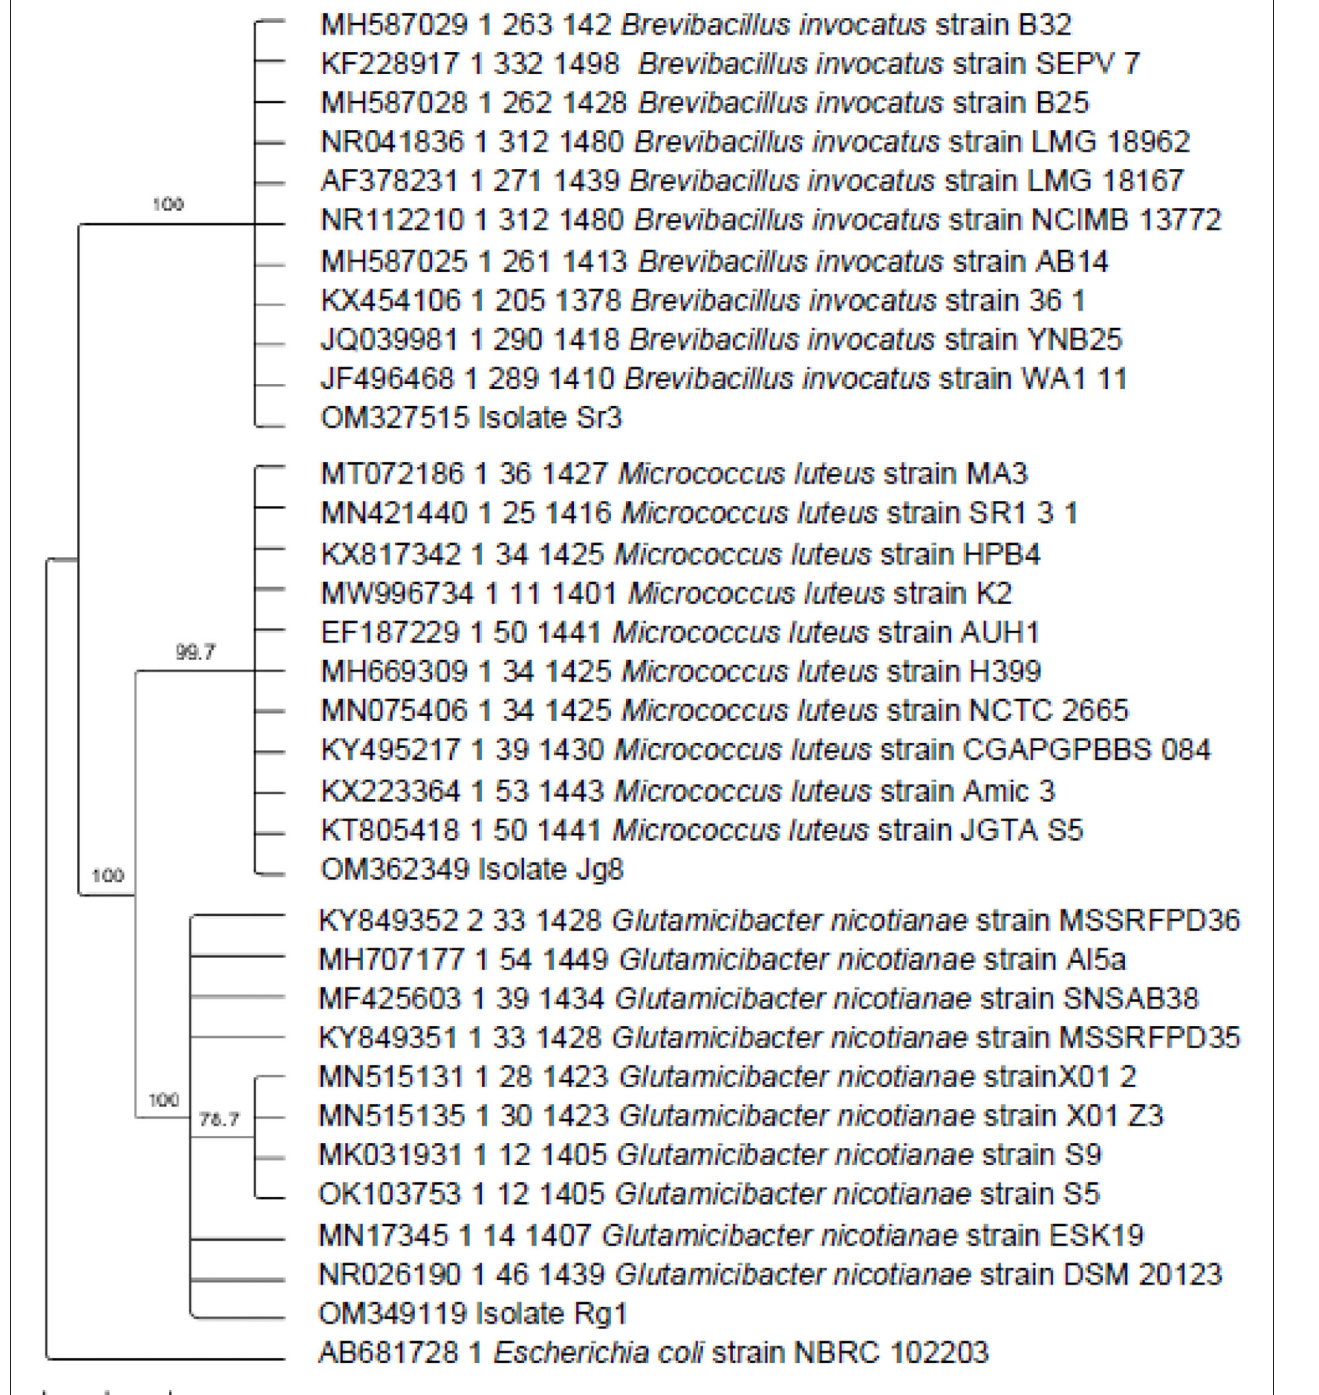
Nitrogen is a macroelement that is critical for the growth and development of plants (Gopalakrishnan et al.,